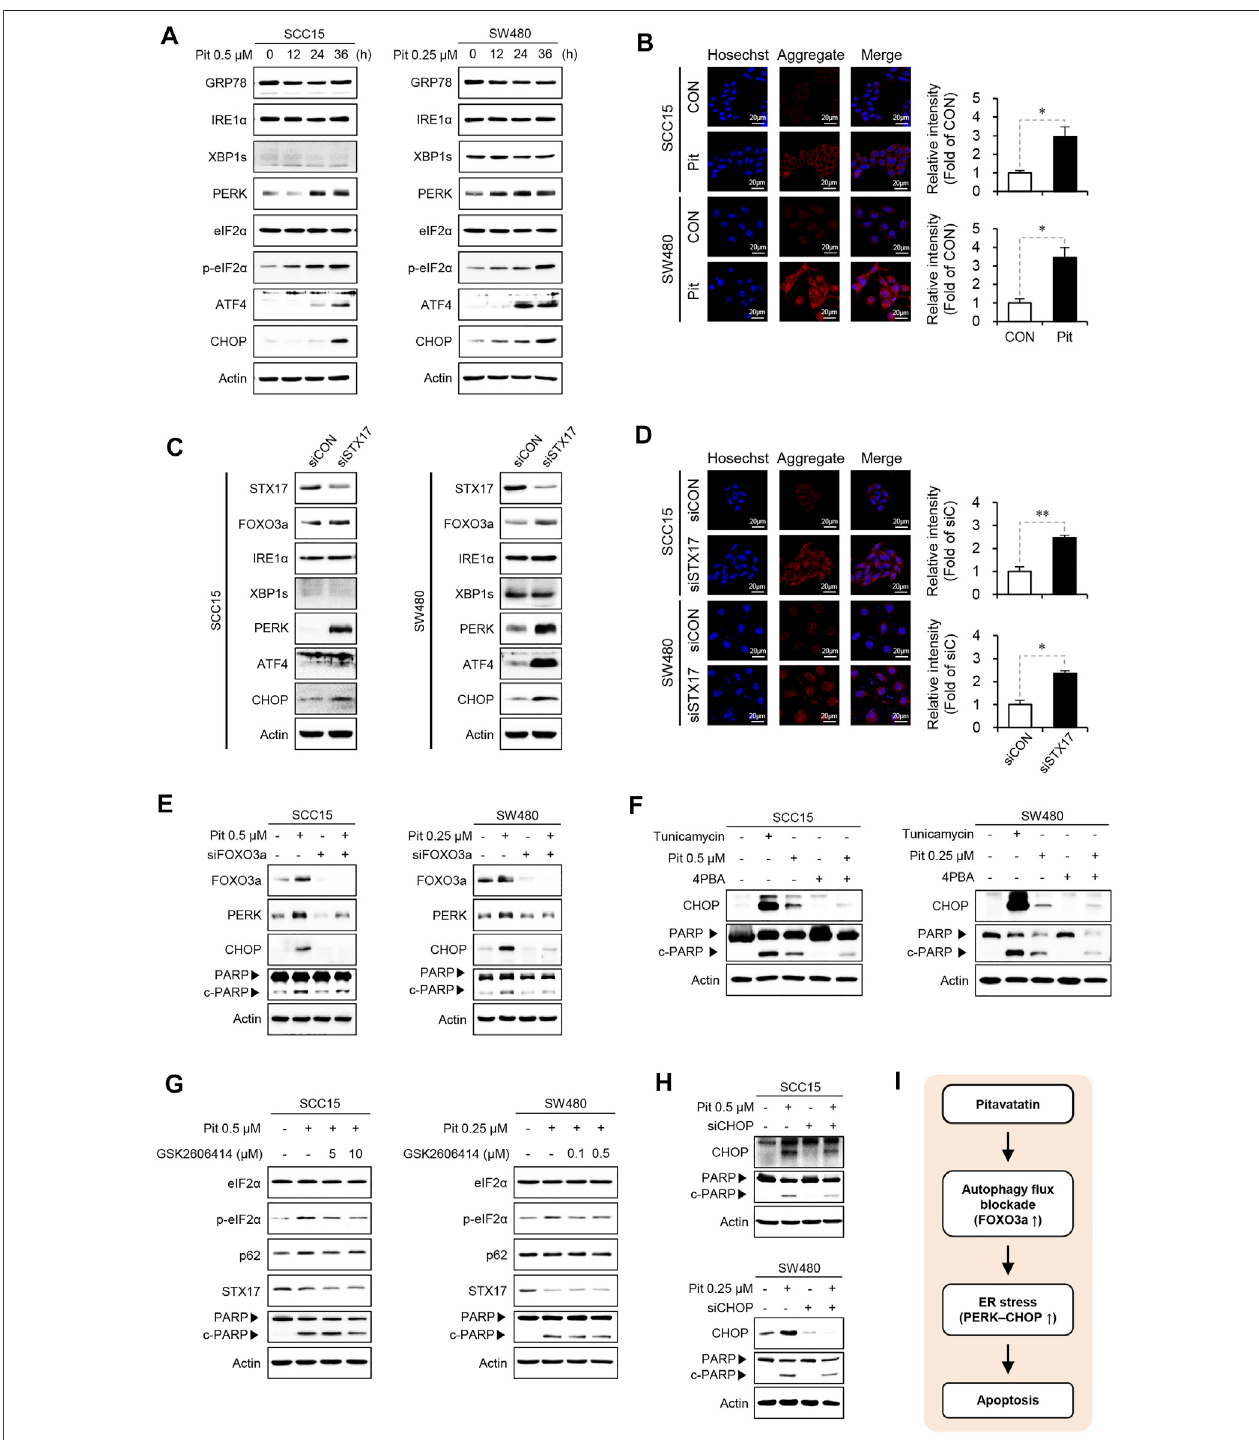
FIGURE 5 | FOXO3a induces ER stress and apoptosis (A) SCC15 and SW480 cells were treated with pitavastatin for the indicated time durations. The protein expressions of GRP78, IRE1 α , XBP1s, PERK, eIF2 α , p-eIF2 α , ATF4, and CHOP were detected by western blot analysis, using actin as the loading control. (B) SCC15 and SW480 cells were treated with pitavastatin for 24 h, cells were stained with proteostat fl uorescent dye, and the formation of protein aggregates was measured by confocal microscopy. Hoechst was used to label the nuclei of cells. The histograms show the quanti fi cation performed using the ImageJ software. Statistical analysis was performed using the Student ’ s t -test. Error bars represent mean ± SD ( n = 3). * p < 0.05. (C) SCC15 and SW480 cells were transfected with STX17 siRNA, andtheexpressionsofindicatedproteinsweremeasuredbywesternblotanalyses.Actinwasusedastheloadingcontrol. (D)